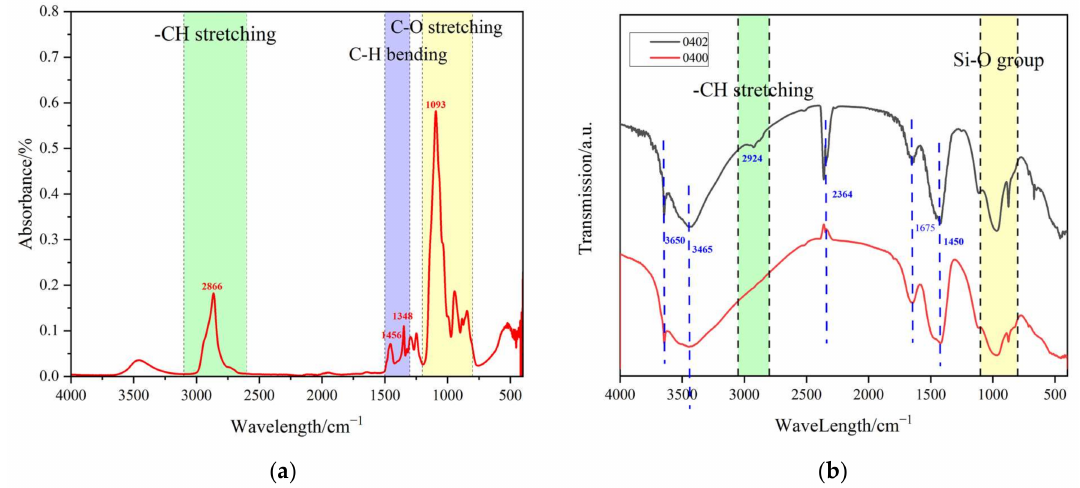
Figure 10. ( a ) FTIR spectra of PEG-600. ( b ) FTIR spectra of cement paste (W/C = 0.4) with PEG-600 0% to